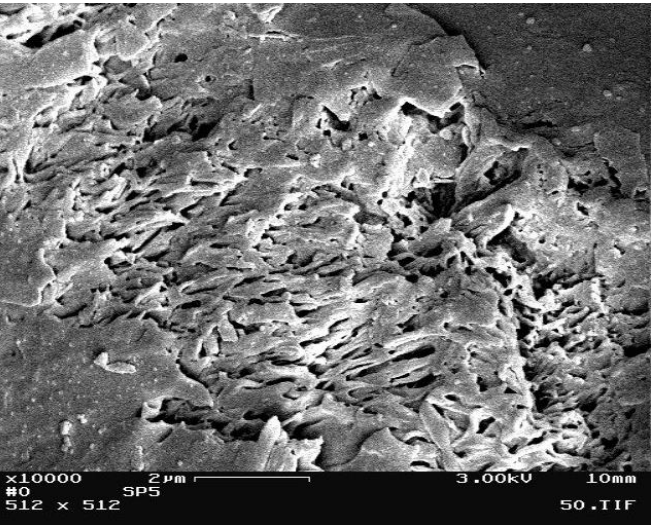
Membranes 2021 , 11 , 292 8 of 15 Figure 3. HRSEM picture of the cross-section of a membrane obtained by the acid etching of nano iron particles after 2 h of etching. The left side is the top of the membrane.